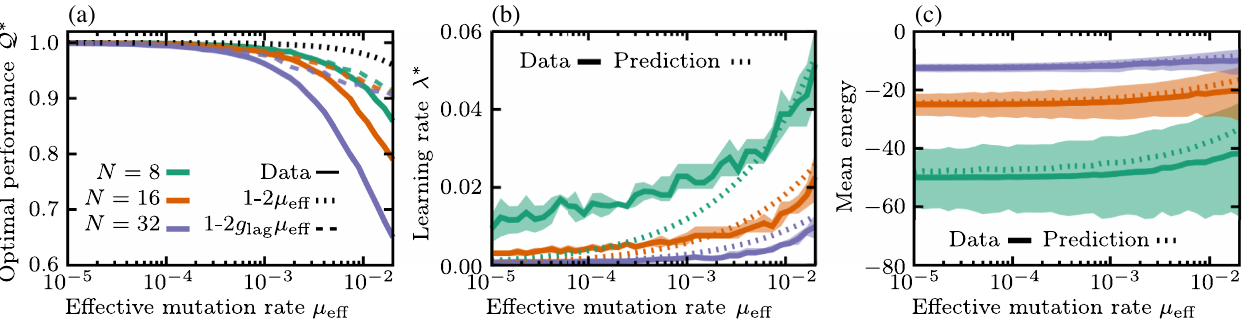
FIG. 2. Reduced performance of Hopfield networks in retrieving memory of evolving patterns. (a) The optimal performance of a N μ . The solid lines show the simulation results network Q (cid:4) ≡ Q ð λ (cid:4) Þ [Eq. (3)] is shown as a function of the effective mutation rate μ eff ¼ for networks encountering different number of patterns (colors). The black dotted line shows the naive expectation for the performance solely based on the evolutionary divergence of the patterns Q 0 ≈ 1 – 2 μ , and the colored dashed lines show the expected performance eff ≈ 1 – 2 g μ after accounting for the memory lag g , Q ; see Fig. S5 in the Supplemental Material [38] for more details. (b) The lag lag lag eff optimal learning rate λ (cid:4) is shown as a function of the effective mutation rate. The solid lines are the numerical estimates, the shaded areas indicate the uncertainty in the estimated optimal learning rate, and dashed lines show the theoretical predictions [Eq. (5)]; see Appendix A and Supplemental Material Fig. S2 [38] for the numerical optimization protocol and the estimation of the uncertainty. (c) The mean energy obtained by simulations of randomly ordered patterns (solid lines) and the analytical approximation [Eq. (4)] for ordered patterns (dotted lines) are shown. Error bars show the standard error from the independent realizations (Appendix A). The color code for the number of presented patterns is consistent across panels, and the length of patterns is set to L ¼ 800